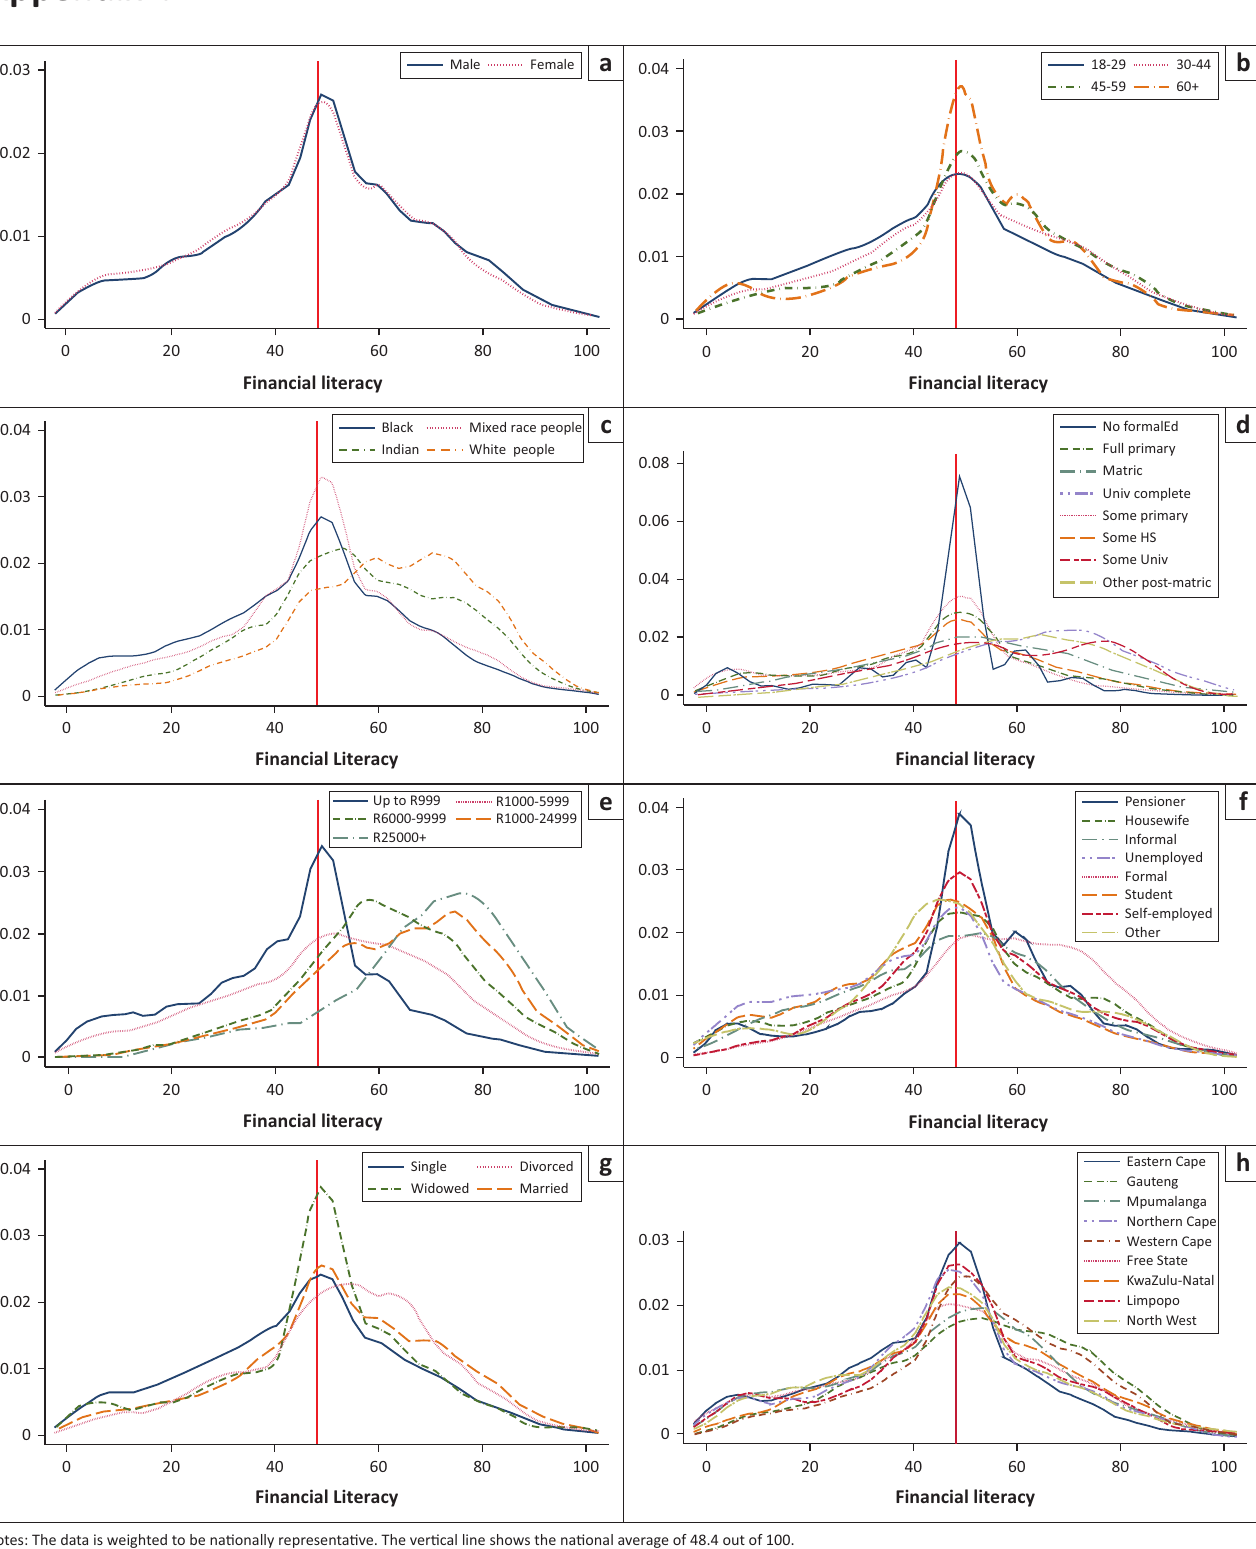
FIGURE 1-A4: The distribution of financial literacy scores in South Africa by the individual’s characteristics (pooled sample): (a) Financial literacy by gender, (b) age group, (c) race, (d) education level, (e) income level, (f) occupation, (g) marital status, (h) province, (i) geo-area and (j) banking